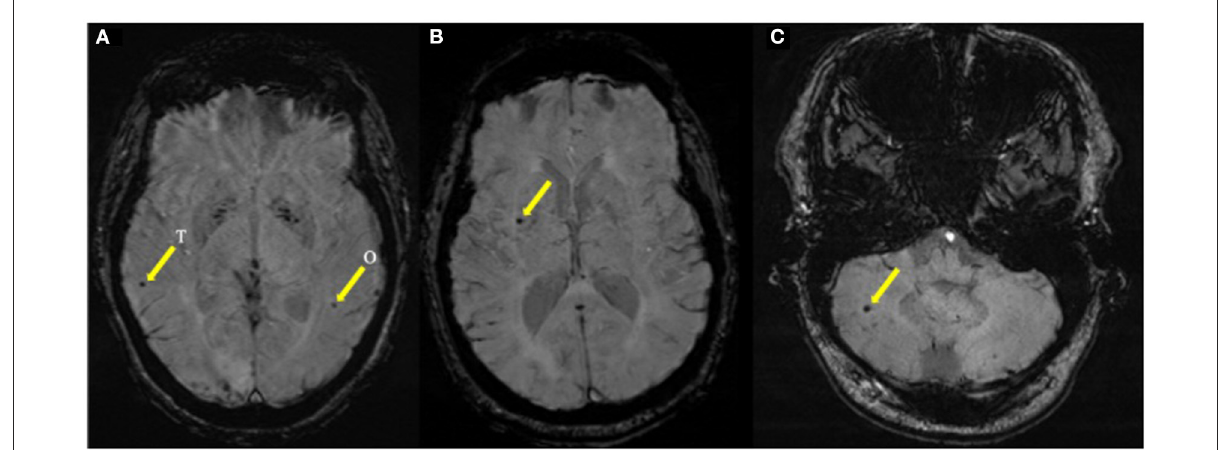
FIGURE1 Representative MRI images of CMB in ischemic stroke patients. (A) Representative SWI sequence in a 72 years-old black female demonstrating two lobar CMB in left occipital lobe (O) and right temporal lobe (T). (B) Representative SWI sequence in a 66 years-old black male demonstrating a deep CMB in the basal ganglia. (C) Representative SWI sequence in a 56 years-old white male demonstrating an infratentorial CMB in the cerebellum.